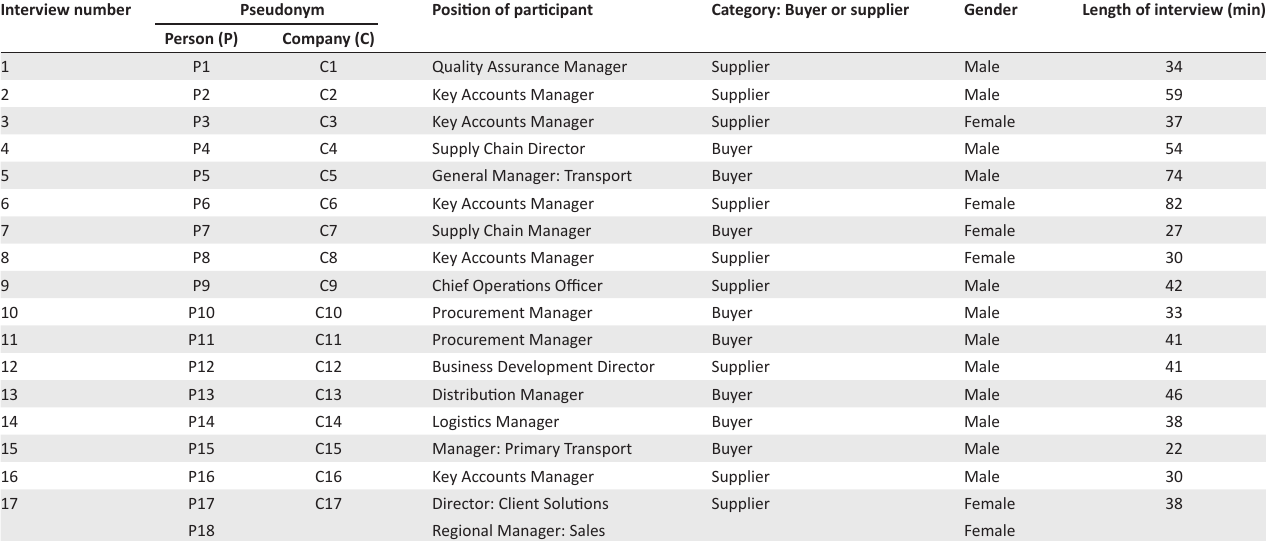
TABLE 1: Participant and company